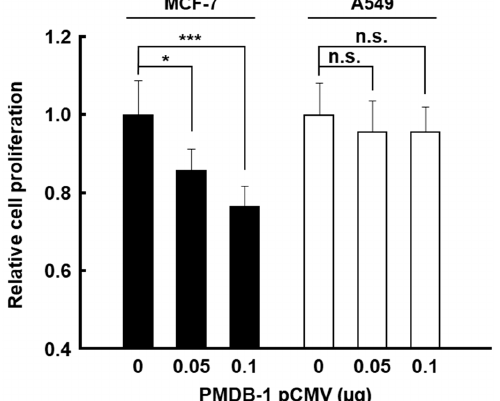
Figure 5. Cell proliferation analysis against PMDB-1 adnectin in MCF-7 cells overexpressing endoge- nous PPM1D or A549 cells with normal level of PPM1D by MTT assay using 96 well plates. Cell growth was determined by MTT assay two days after transfection. Cell proliferation values were calculated as the signal derived from PMDB-1-treated cells relative to the signal derived from parent cells without plasmid vector. These experiments were performed in triplicate, and two independent experiments were carried out. Bar graphs show the means ± SDs. *: p < 0.05, ***: p <0.005.